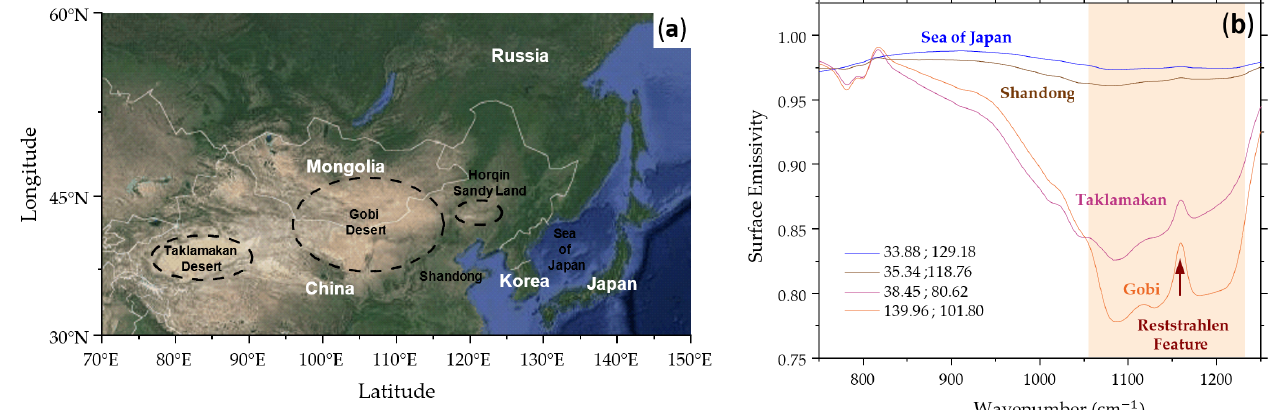
Figure 3. ( a ) Topographic map of East Asia region with dashed black circles around the main desert sources; ( b ) mean monthly surface emissivity of four different surfaces during the month of May (Adapted with permission from Ref. [44], 2021, Daniel Zhou). The shaded orange box indicates the Reststrahlen region.